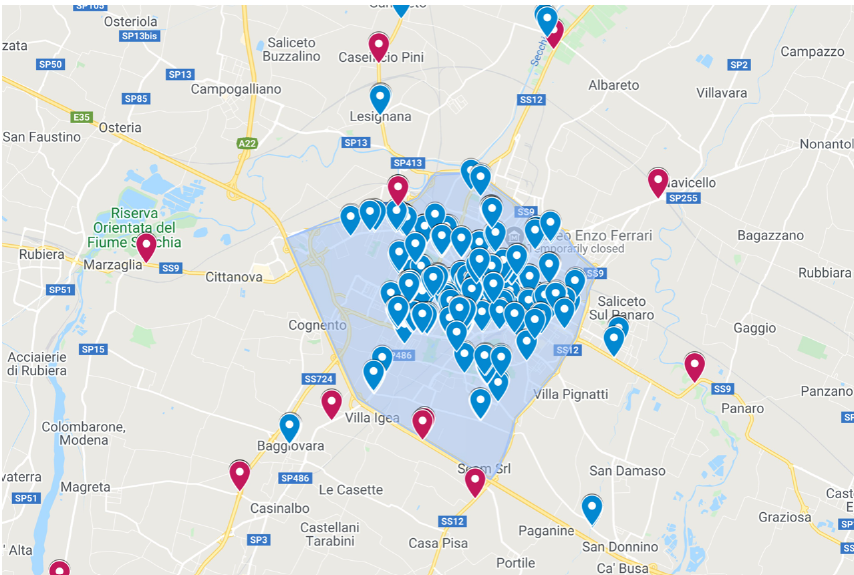
Figure 1. Induction loops in Modena (the blue and magenta markers indicate the position of sensors managed by the City Council and the Emilia Romagna Region, respectively). Map data: Google,